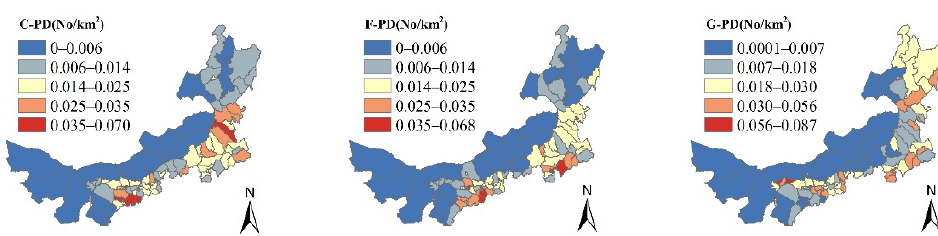
Figure 6. The spatiotemporal evolution of PD in Inner Mongolia from 2000 to 2015. Note: C, cropland; F, forestland; G, grassland; PD, patch density.